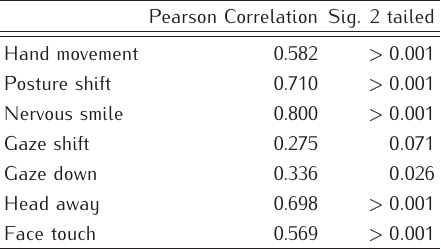
Table 4. Pearson’s correlation between the two raters.